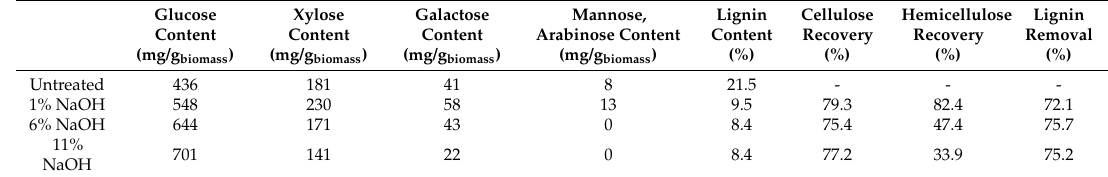
Table 2. Composition of raw biomass and obtained hydrolysates.